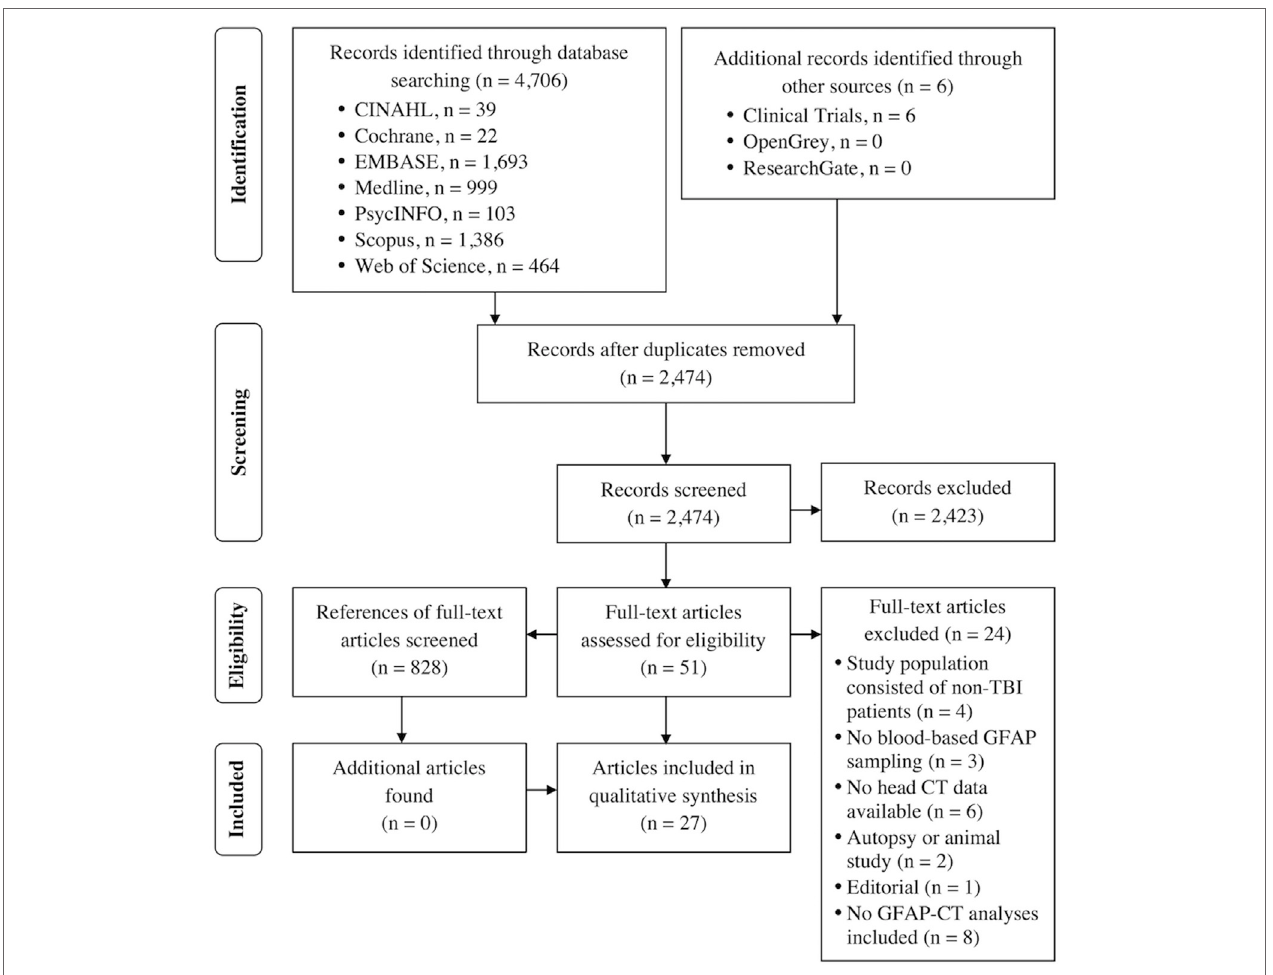
FiGURe 1 | PRISMA flow